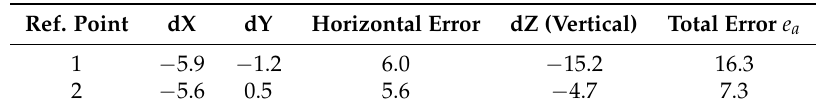
Figure 26. Geodetic survey markers painted on the road ( a ) is also visible in the point cloud ( b ) thanks to the coloring by laser intensities. Table 4. Errors measured (cm) on geodetic survey marker points at the beginning and at the end of survey track. The distance between the control points is 523